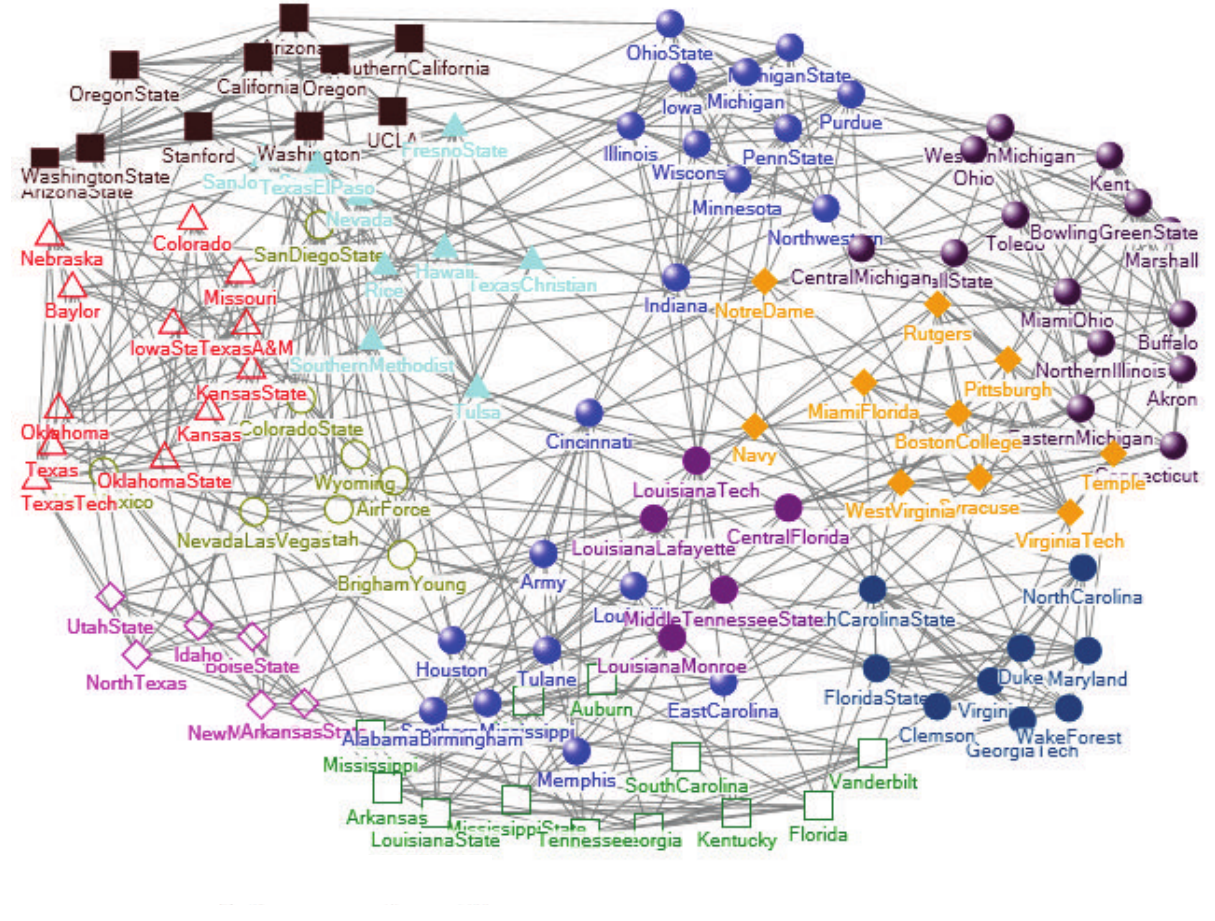
Figure 4: The community detection results by our algorithm.